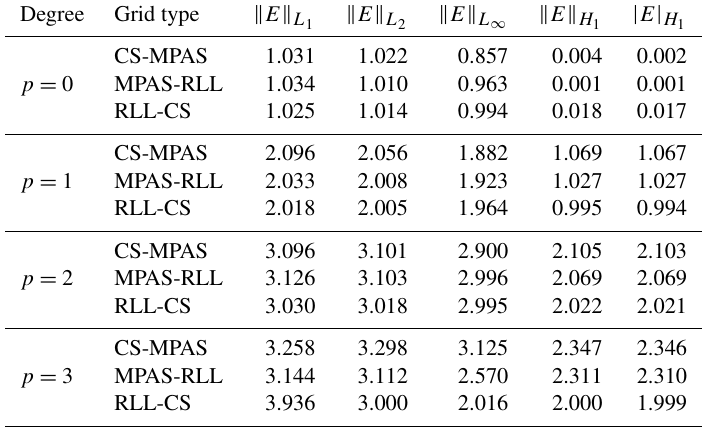
Table 3. TempestRemap: convergence rates for the A NALYTICAL F UN 1 field on all mesh types. Degree